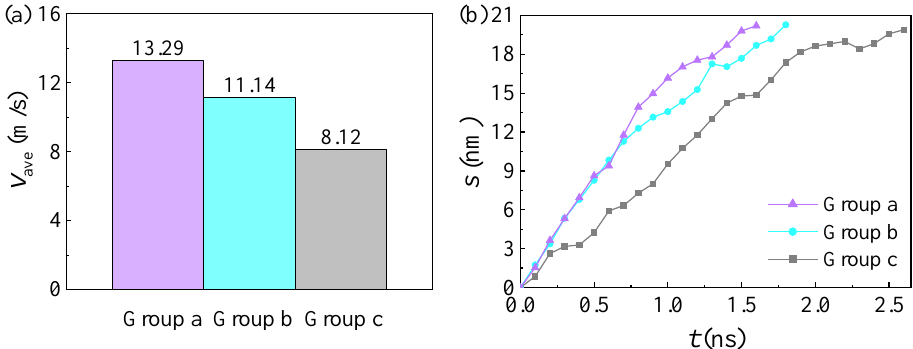
Figure 10. Influences of the droplet temperature: ( a ) Average motion velocity of the droplets at different temperatures; ( b ) Motion courses of the droplet over time at different temperatures.